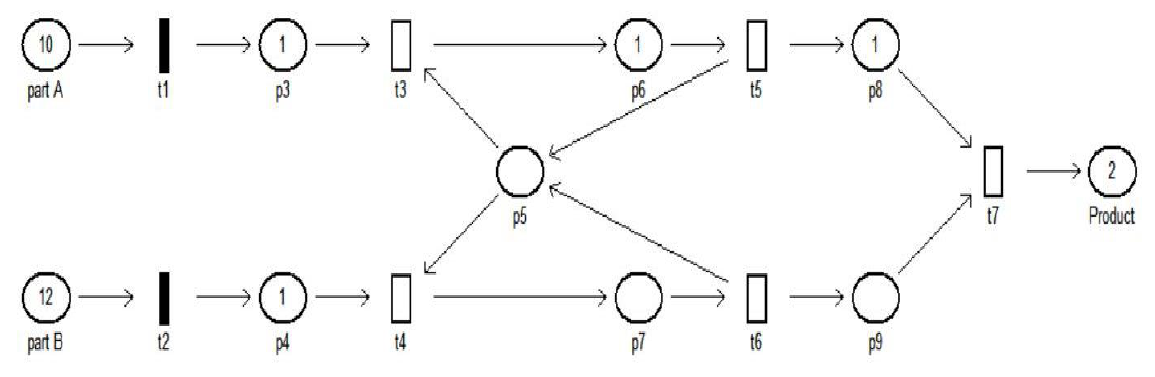
Figure 3: Simulation of the system